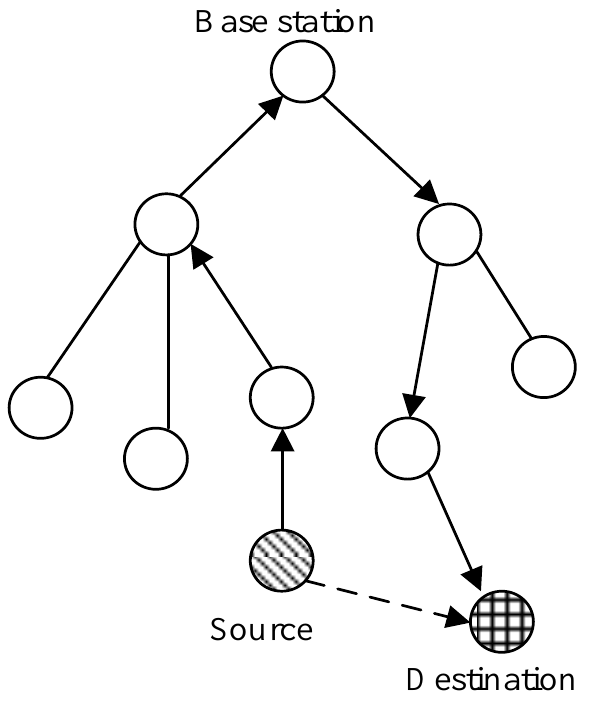
Figure 3. Drawbacks of the cluster-tree protocol .